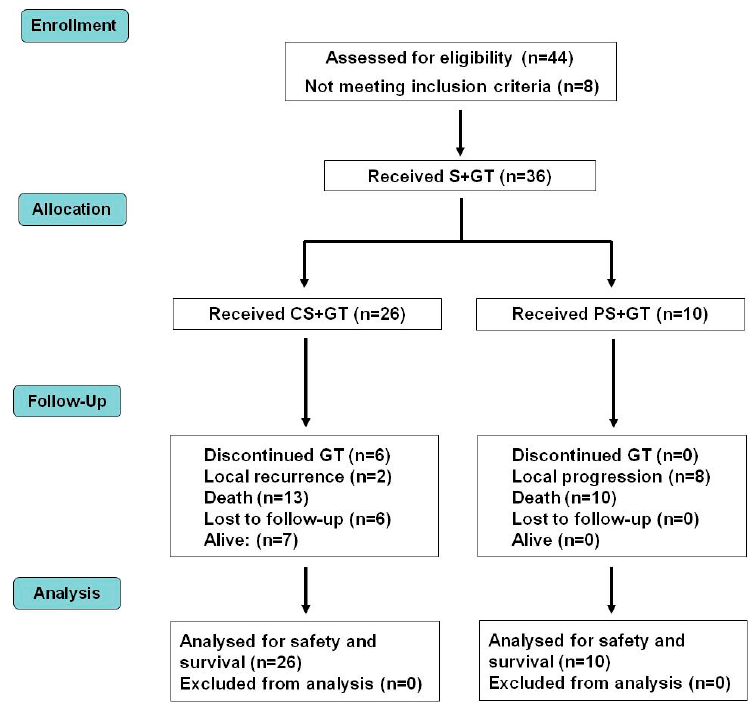
Figure 2. Distribution of patients in a CONSORT diagram. CS—complete surgery; GT—gene therapy; PS—partial surgery; S—surgery.